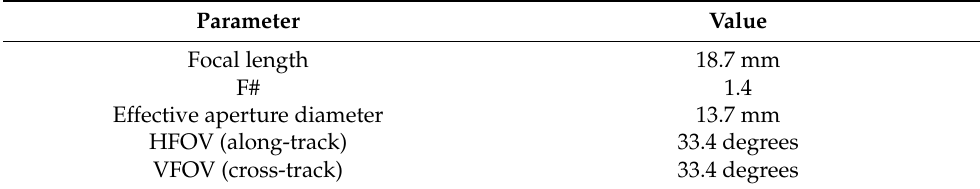
Table 4. Main features of the selected optics for HORUS payload.